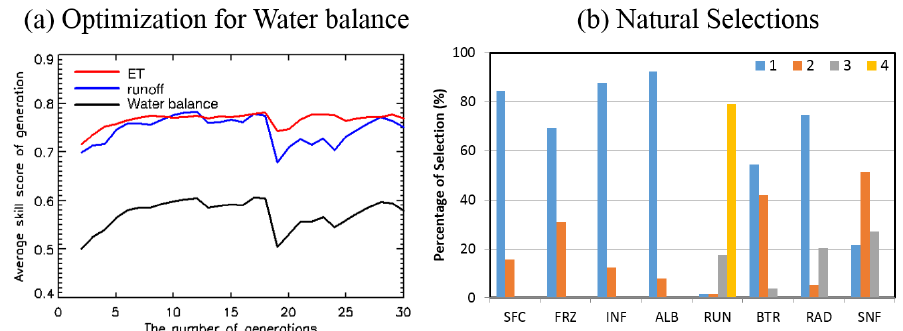
Figure 5. (a) Evolution of generations during the process of the MP–MGA optimization for the WB estimation as in Fig. 3, and (b) percentage of selections of each scheme to the total number of simulations during the optimization process as in Fig.